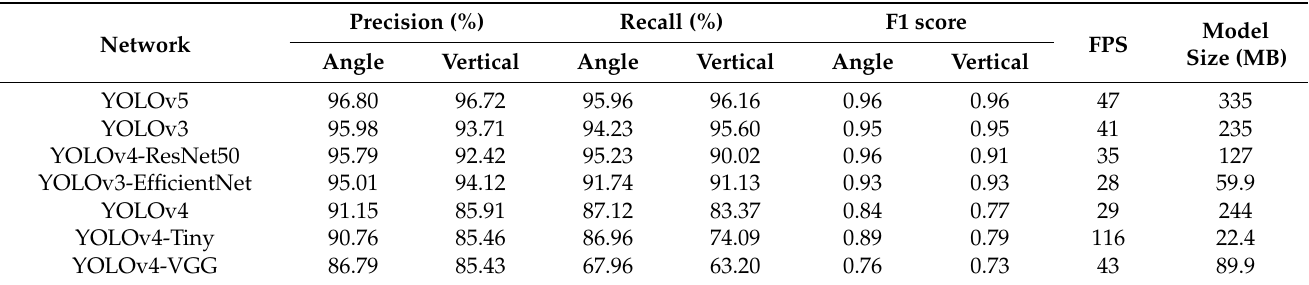
Table 2. Detection results of seven detection networks.